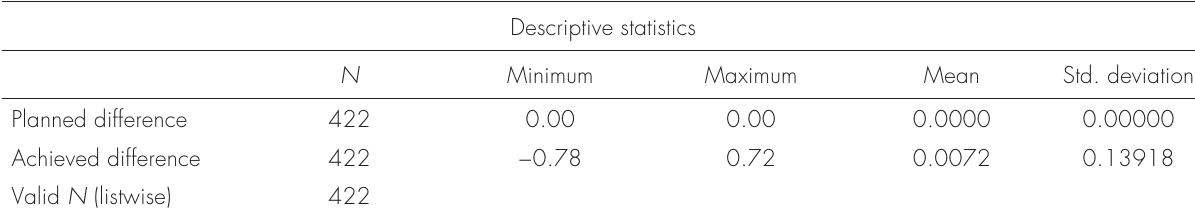
Table III. Planned and achieved tooth width differences in pilot study of 40 cases.